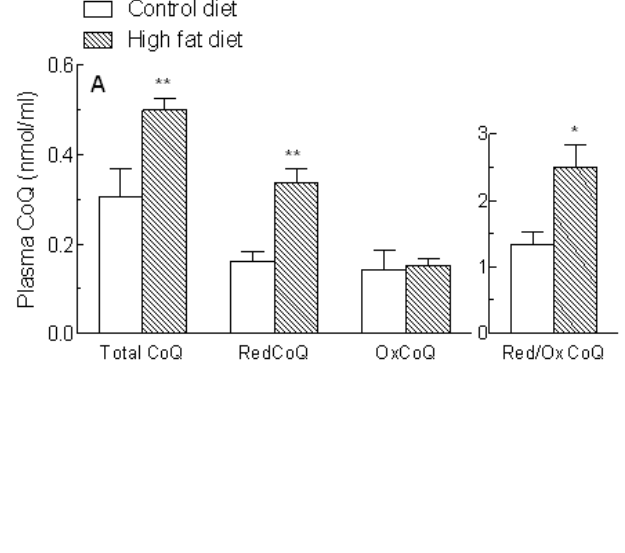
Figure 3. Plasma Coenzyme Q (CoQ) levels in rats fed a standard low fat (Control diet) or a high fat diet for 18 weeks. Blood samples were collected and the concentrations of reduced (RedCoQ) and oxidised (OxCoQ) CoQ9 and CoQ10 in plasma were determined. Total CoQ values are RedCoQ + OxCoQ. ( A ) CoQ (CoQ9 + CoQ10) and RedCoQ/OxCoQ; ( B ) CoQ9 and RedCoQ9/OxCoQ9; ( C ) CoQ10 and RedCoQ10/ OxCoQ10; Data are the mean from 6 (Control diet) or 10 (High fat diet) animals and error bars show the SEM. * P < 0.05, ** P < 0.01, *** P < 0.001 vs. Control